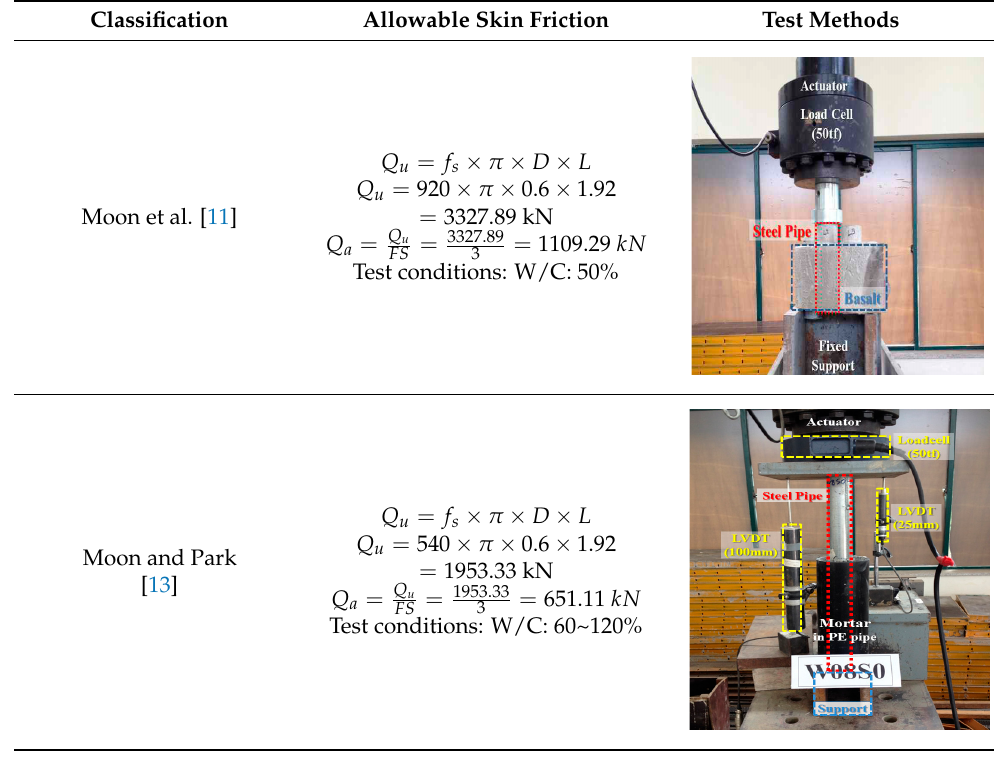
Table 4. Allowable skin friction between tension member and grout.